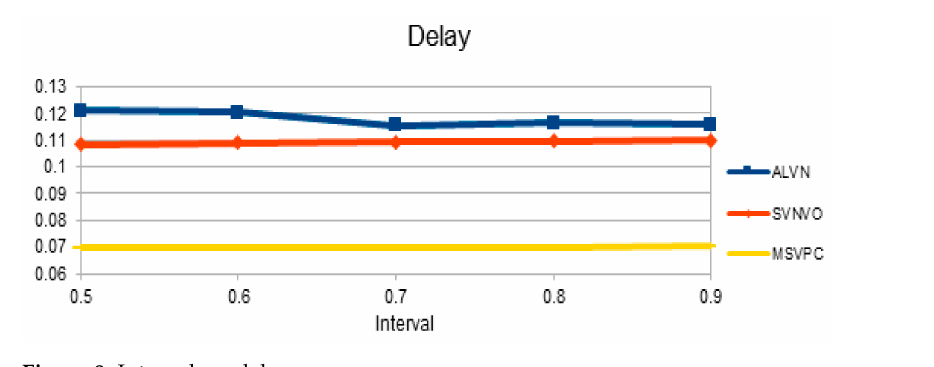
Figure 7. Packet delivery ratio.